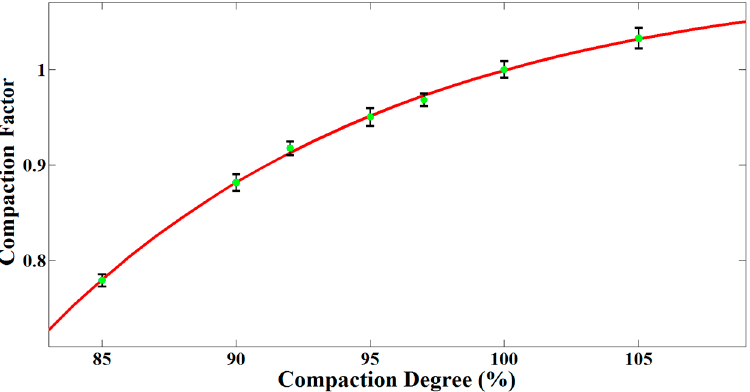
Figure 8. The fitting relationship between compaction degree and the compaction factor. The green dots are compaction factors calculated from measured dielectric constants. The error bars show the triple standard derivation. The red curve indicates the fitting function.